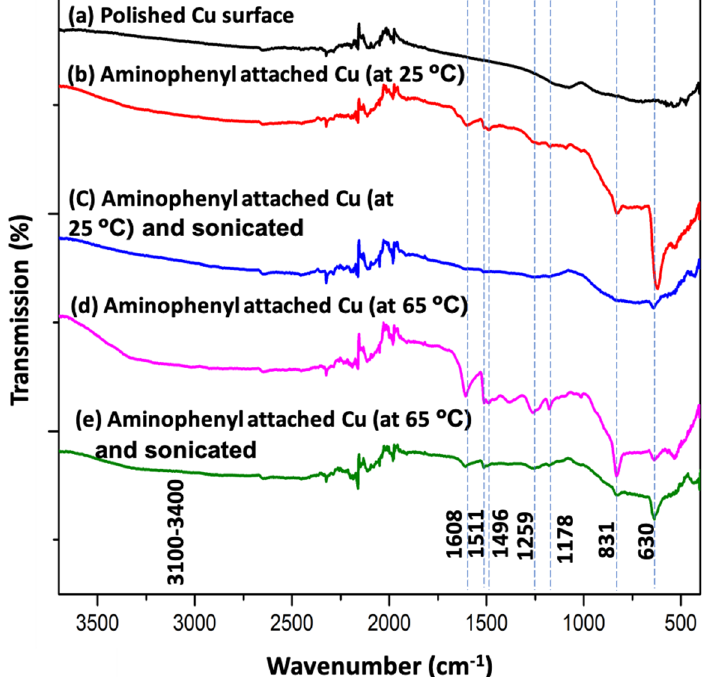
Figure 3. FTIR spectra of organic grafted Cu surface. Normalized FTIR spectra of ( a ) polished Cu surface, ( b ) aminophenyl group attached to Cu surface at 25 °C, ( c ) aminophenyl group attached to Cu surface at 25 °C after sonication, ( d ) aminophenyl group attached to Cu surface at 65 °C, and ( e ) aminophenyl group attached to Cu surface at 65 °C after sonication.